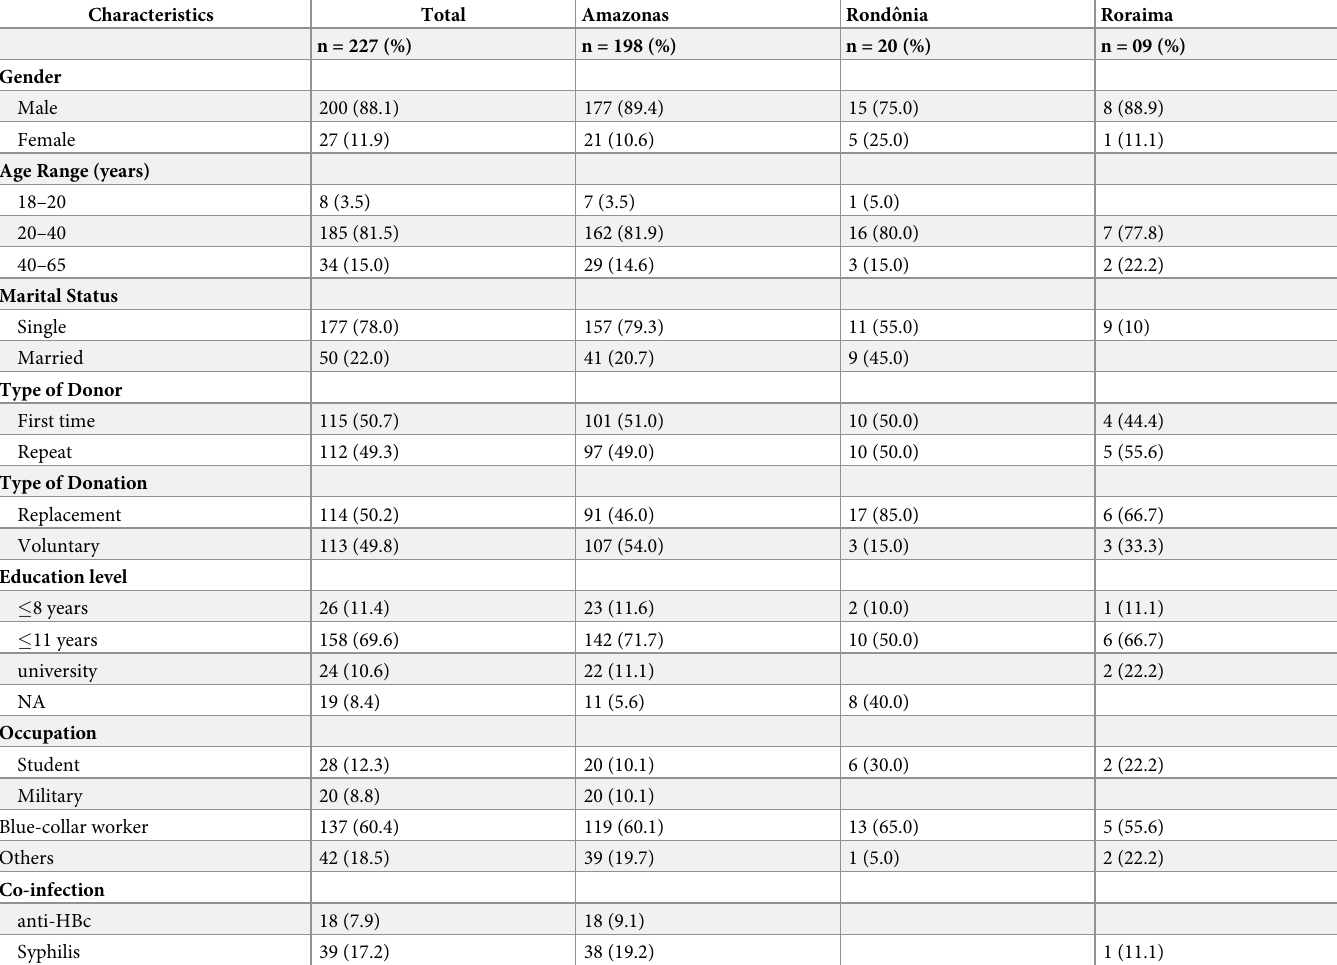
Table 1. Main socio demographic and donation characteristics of HIV-1 infected blood donors from Amazonas, Rondoˆnia and Roraima states in the Brazilian Amazon.